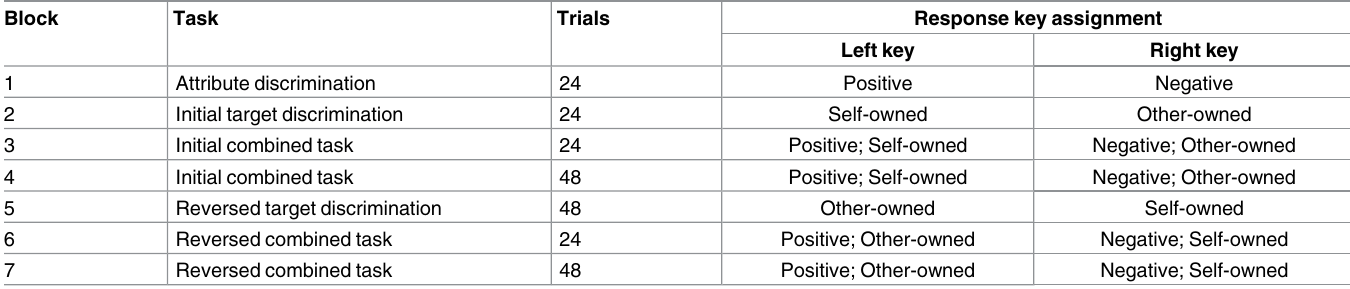
Note. Positive = positive adjectives; Negative = negative adjectives; Self-owned = self-owned objects; Other-owned = other owned objects. Participants pressed the left and right key to classify the word that appeared on the screen. The order of the IAT blocks as well as the objects assigned to self-owned versus other-owned were counterbalanced between subjects.